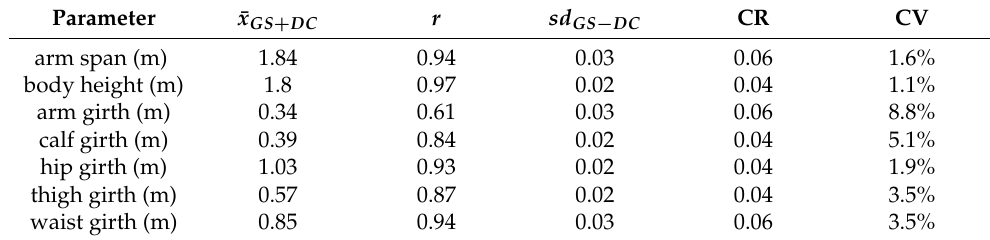
Table 2. Results of correlation and Bland–Altman